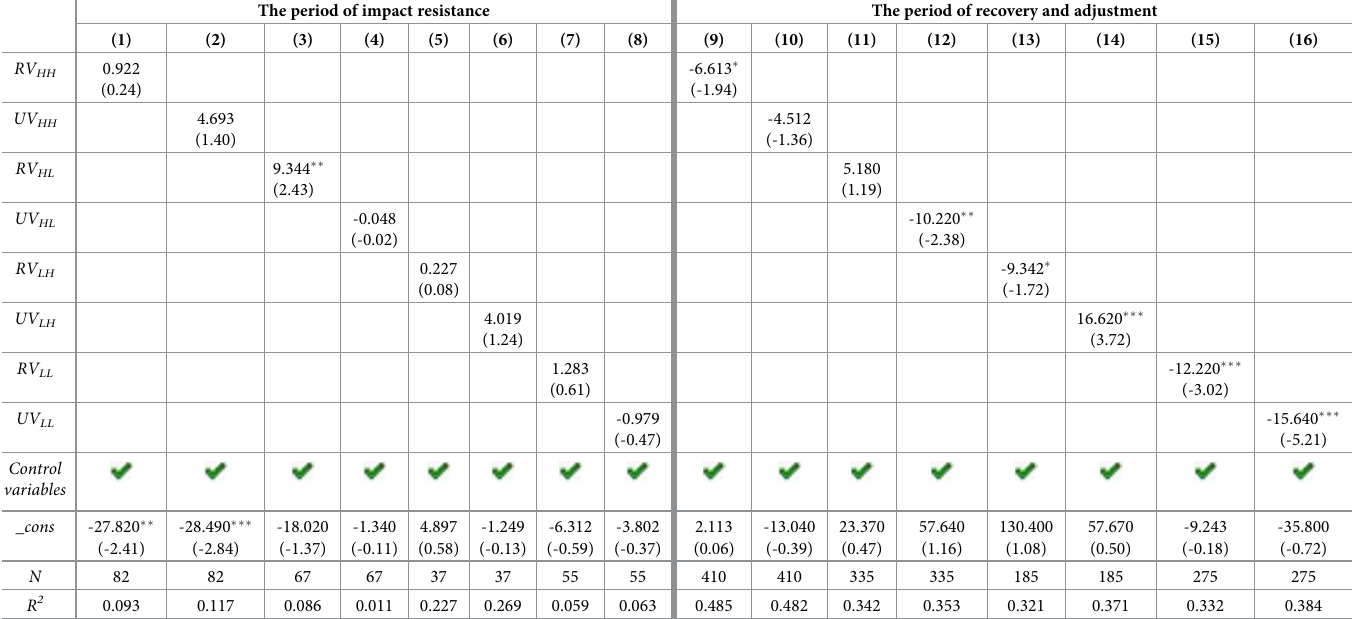
Table 7. The effects of dual industry diversified agglomeration on urban economic resilience. The period of impact